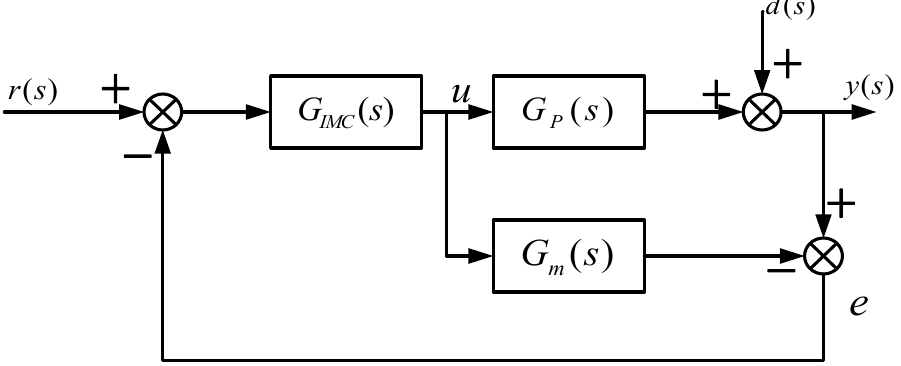
Figure 1. Design of internal model control structure.